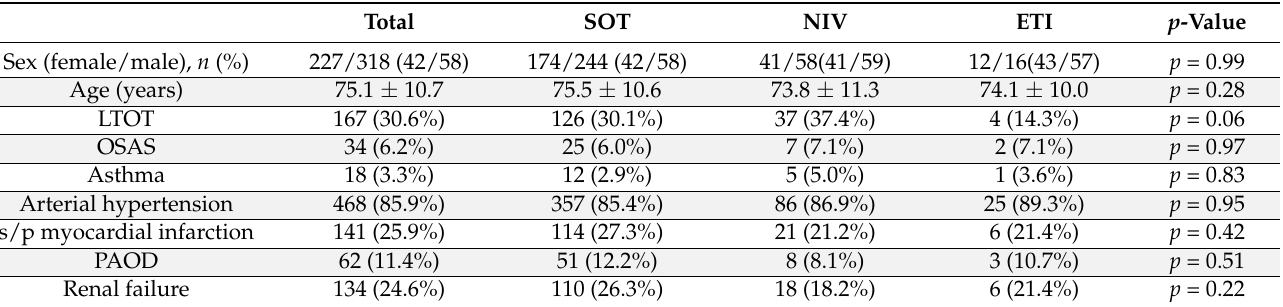
Table 1. Demographic data and baseline